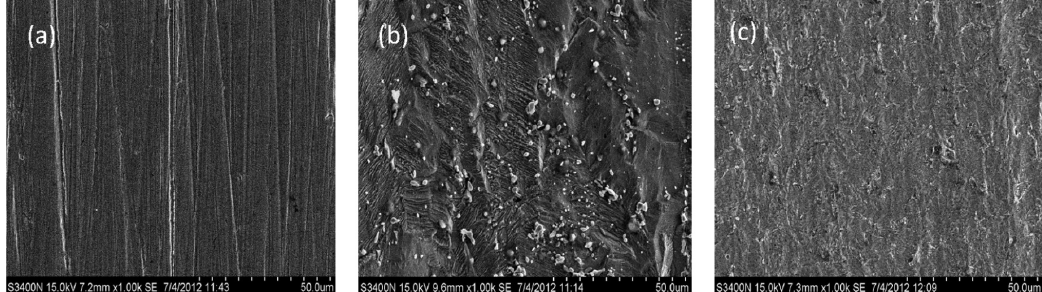
Figure 1. SEM images of steel surfaces under different corrosion testing conditions: ( a ) polished sample before testing; ( b ) sample immersed in the corrosion solution (HCl, 10 wt. %) without amino acid pre-treatment; and ( c ) sample immersed in the corrosion solution with 0.090 g L −1 amino acid pre-treatment for 2 h [27].